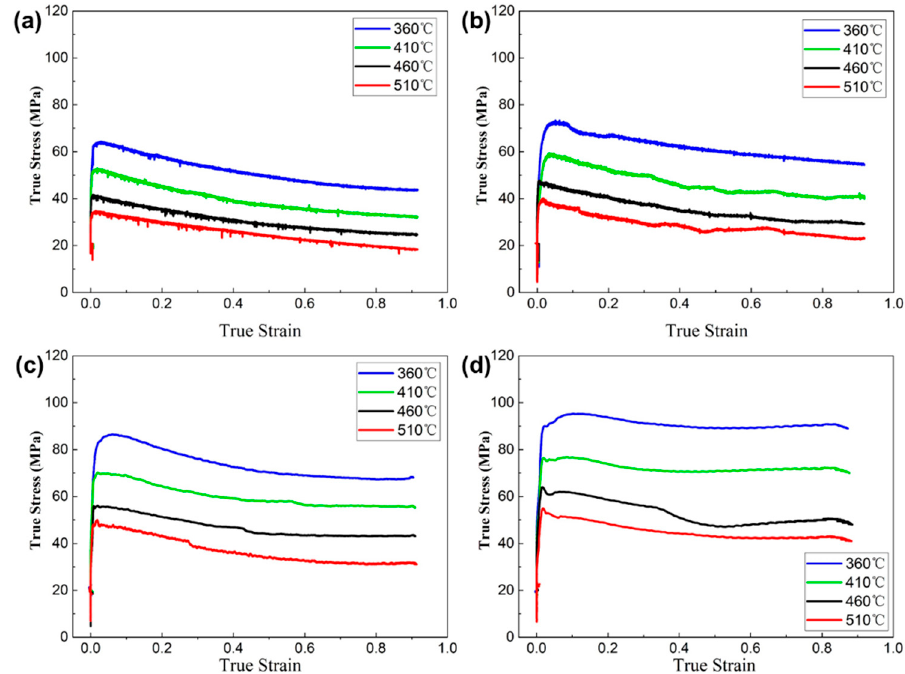
Figure 8. The true stress–strain curve of the fifth layer of gradient alloy by spray deposition: ( a )